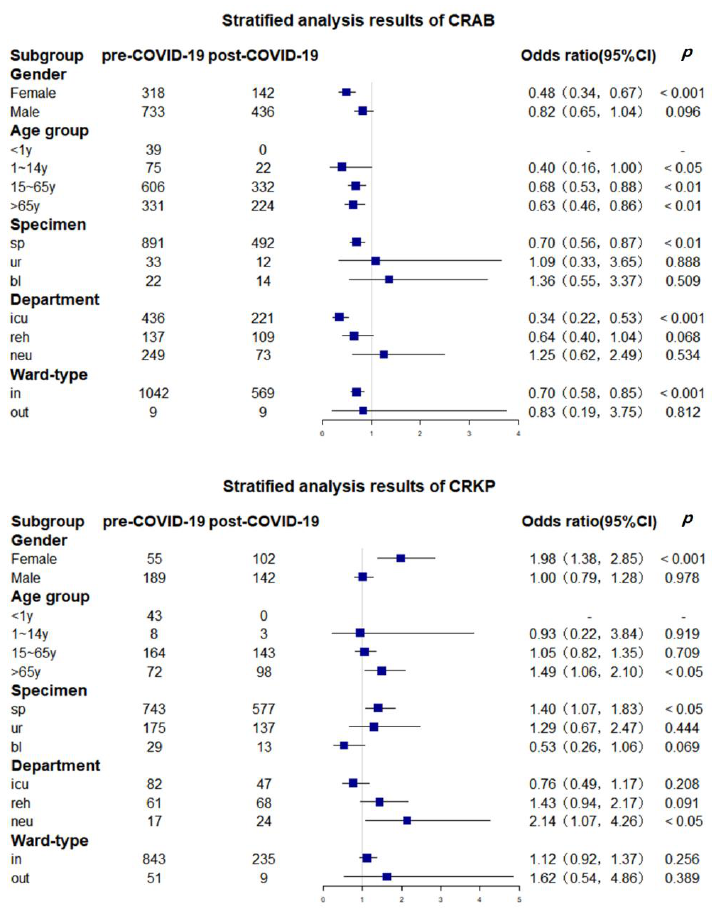
Figure 3. The change in CROs before and after COVID-19 in different subgroups. The sample size of outpatients was too small to be included in the stratified analysis. Abbreviations: sp, sputum; ur, urine; bl, blood; icu, intensive care unit; reh, rehabilitation center; neu, neurology.